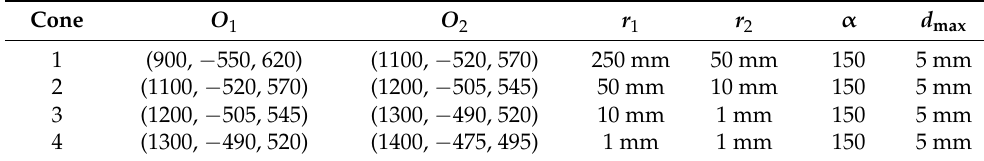
Table 1. Parameter setups of the virtual fixture.